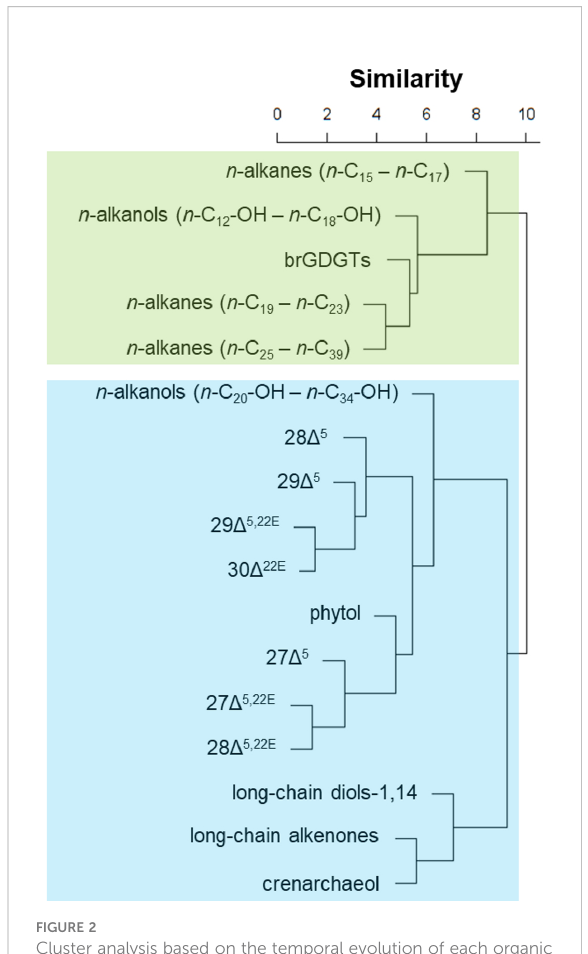
FIGURE 2 Cluster analysis based on the temporal evolution of each organic compound group, using the SAX representation as the dissimilarity measure. The green rectangle indicates the “ terrestrial-source ” group and the blue rectangle indicates the “ marine-source ”